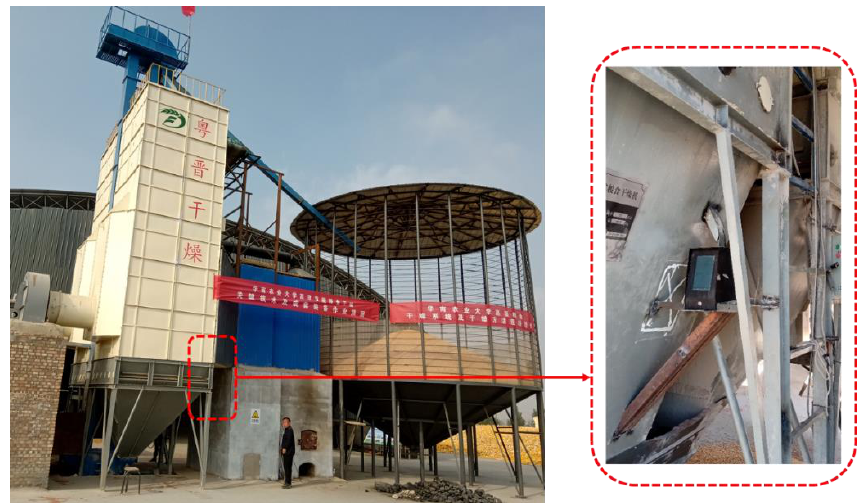
Figure 3. Installation position of the online moisture content device in the drying process.